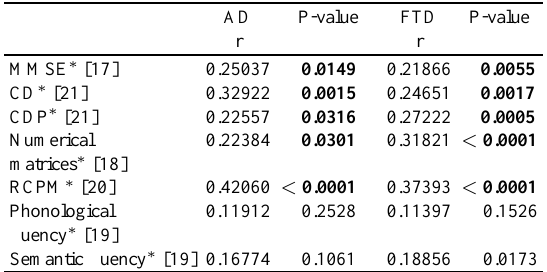
Table 1 Comparison of main demographic and neuropsychological data of the two groups of patients